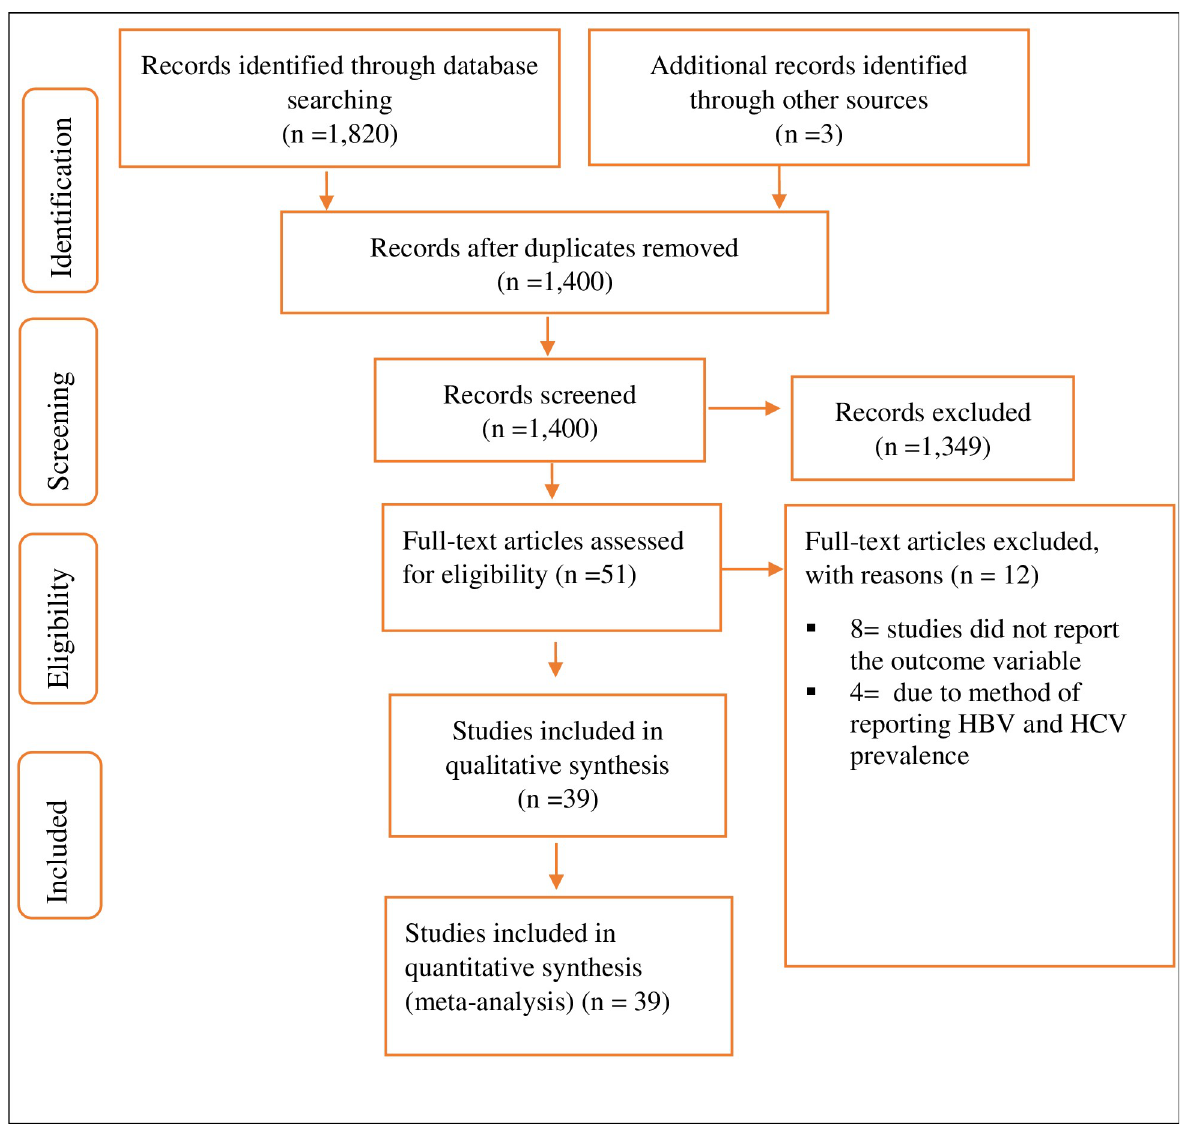
Fig 1. Flow chart to describe the selection of studies for the systematic review and meta-analysis on the prevalence of HBV and HCV infection among HD patients.